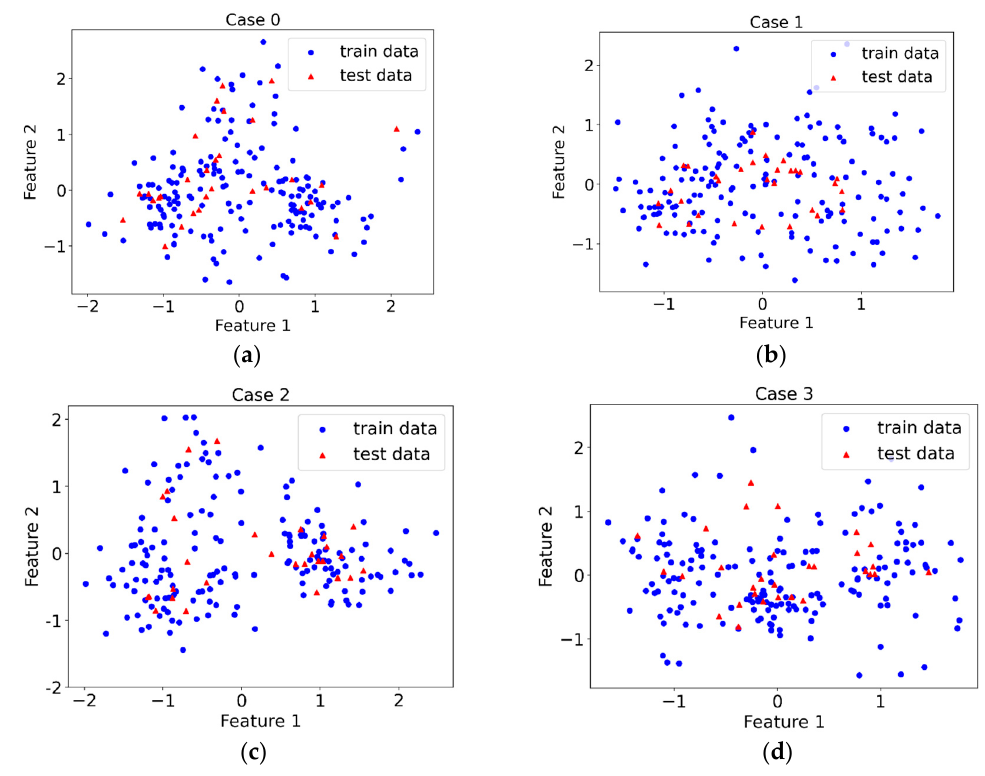
Figure 12. PCA visualization results. ( a ) Case 0, ( b ) Case 1, ( c ) Case 2, ( d ) Case 3.